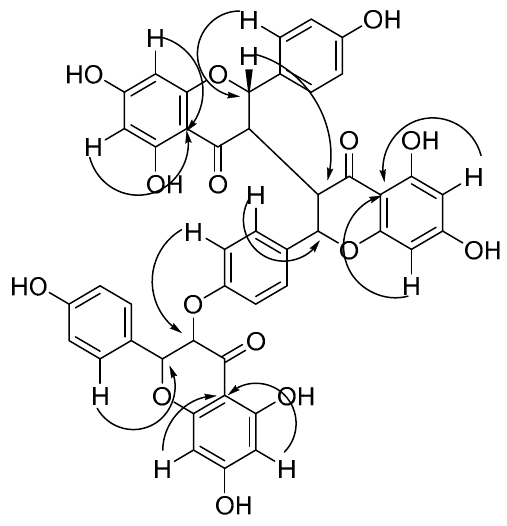
Figure 2. HMBC correlations of compound 1 .